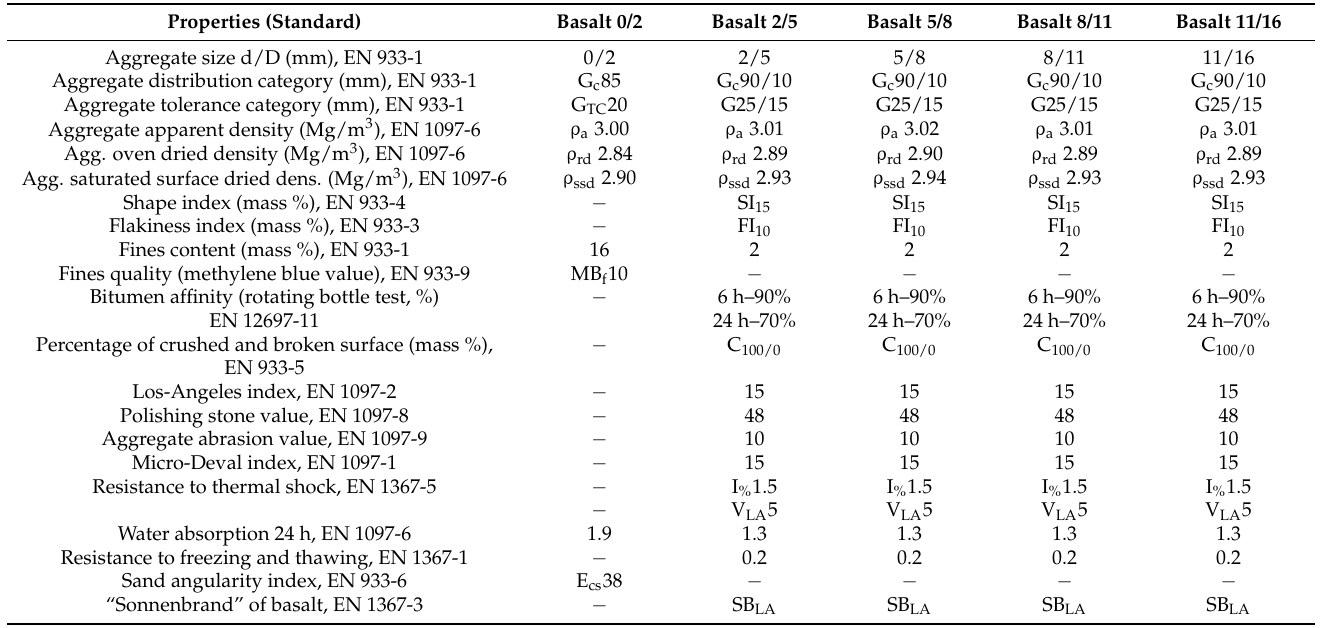
Table A1. Properties of basalt aggregate used in “B” type mixes (results by the producer). Properties